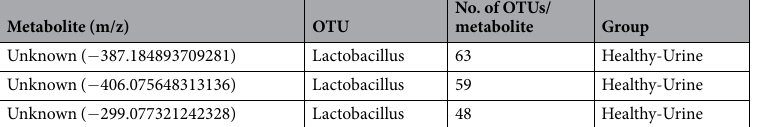
Table 3. List significant microbe-metabolite interactions by group and sample-type. Significant positive interactions were determined by pairwise Pearson correlations between OTUs and metabolites significantly enriched in the respective groups (i.e. Healthy-Urine). All FDR-corrected p-values are < 0.05, and r > 0.6. Only showing interactions with > 10 No. of OTUs/metabolite. Metabolites are listed with their mass:charge (m/z) ratios. Negative values indicate metabolites identified in negative electron spray ionization mode, whereas positive values indicate metabolites identified in positive mode. Group indicates cohort (healthy or USD) and the sample type (urine or